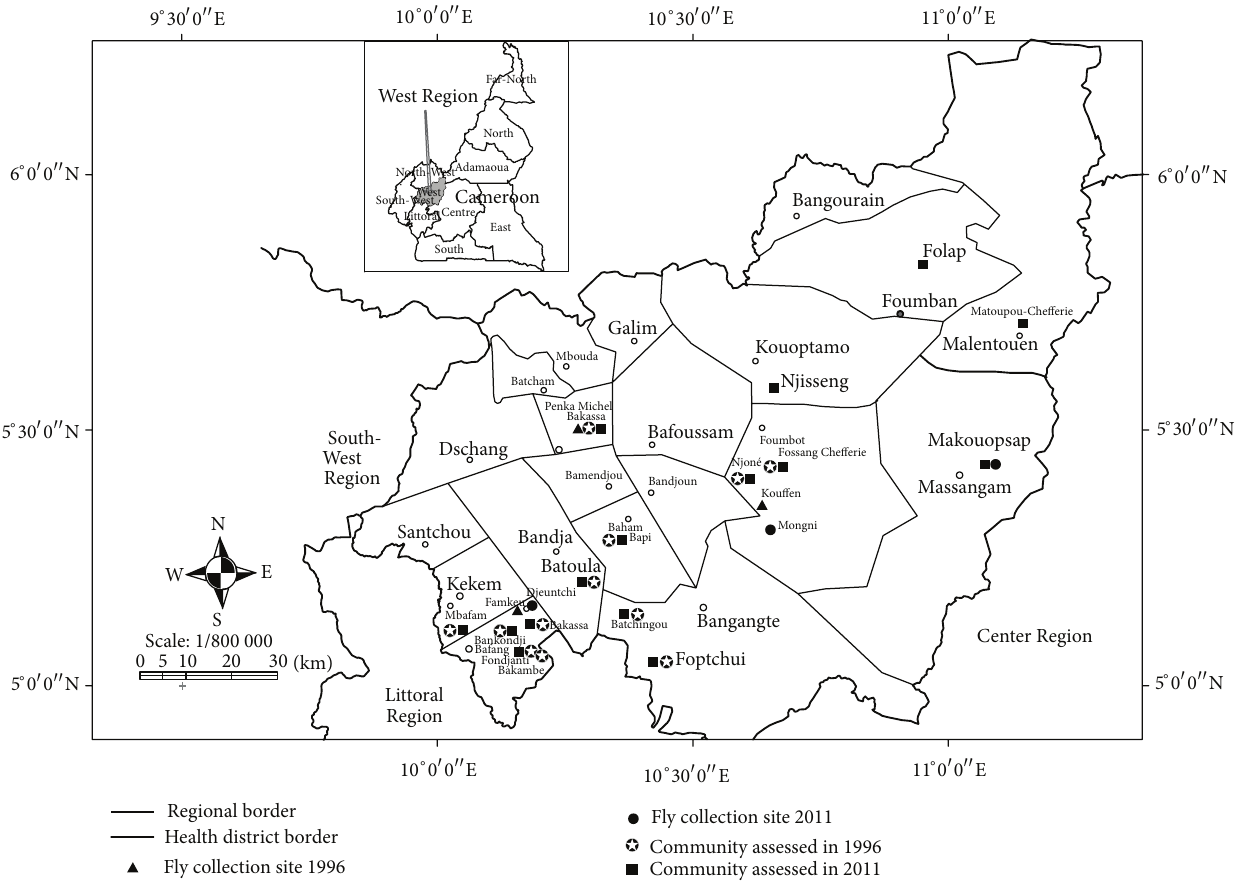
Figure 1: Map of West Region of Cameroon showing the study